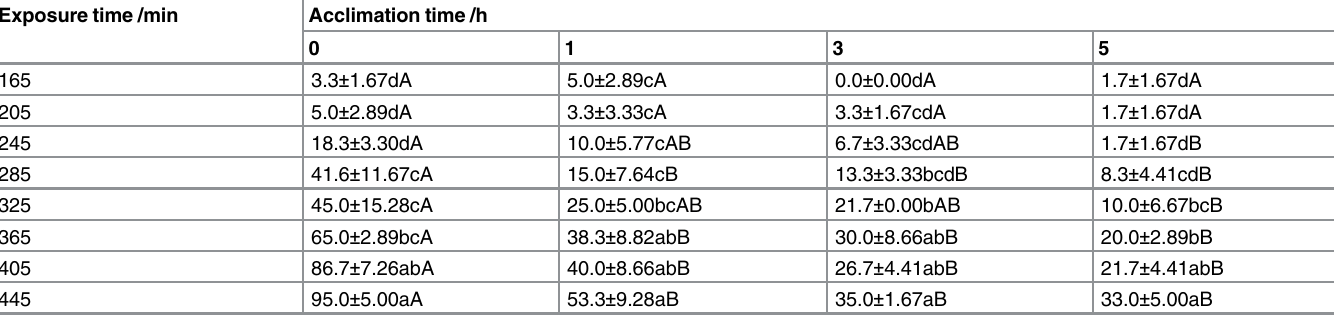
Note: Data are Mean ± SE of three replicates. Different lowercases indicate signi fi cant differences in the same column, and different capital letters indicate signi fi cant differences in the same row (p < 0. 05. The same as Tables 3, 5 and